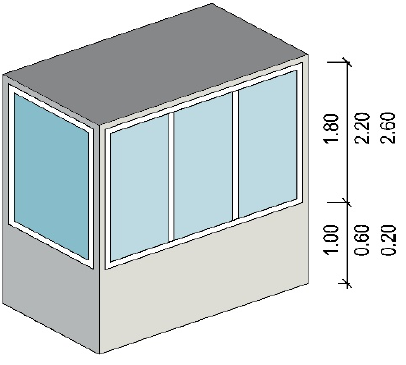
Figure 2. Glazing height and layout.